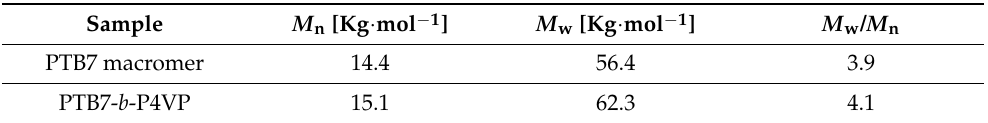
Table 1. MWDs of the macromer PTB7 and the rod–coil PTB7- b -P4VP determined by size exclusion chromatography using THF:DMF = 80:20 as the eluent.